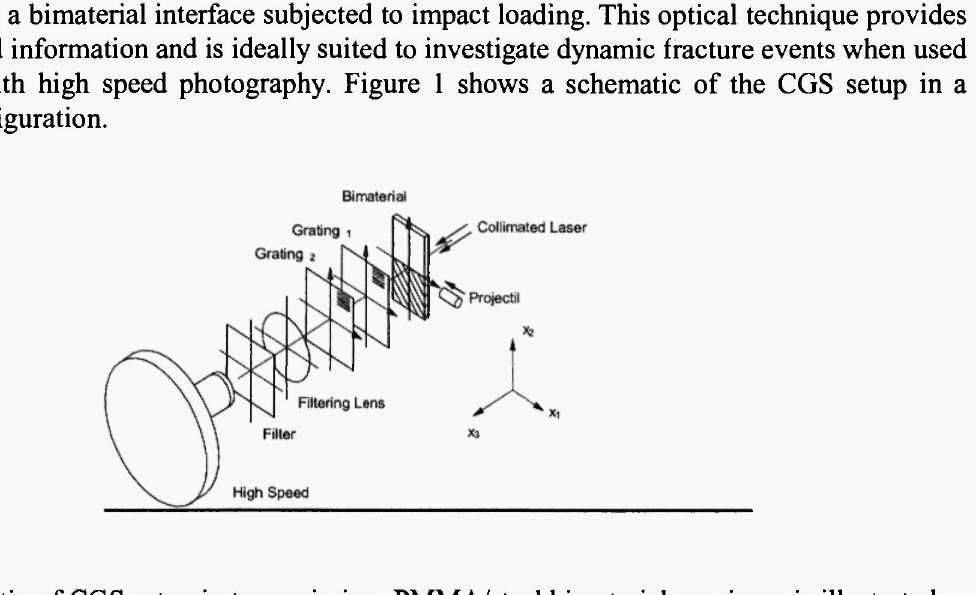
Figure 1: Schematic of CGS setup in transmission. PMMA/steel bimaterial specimen is illustrated.